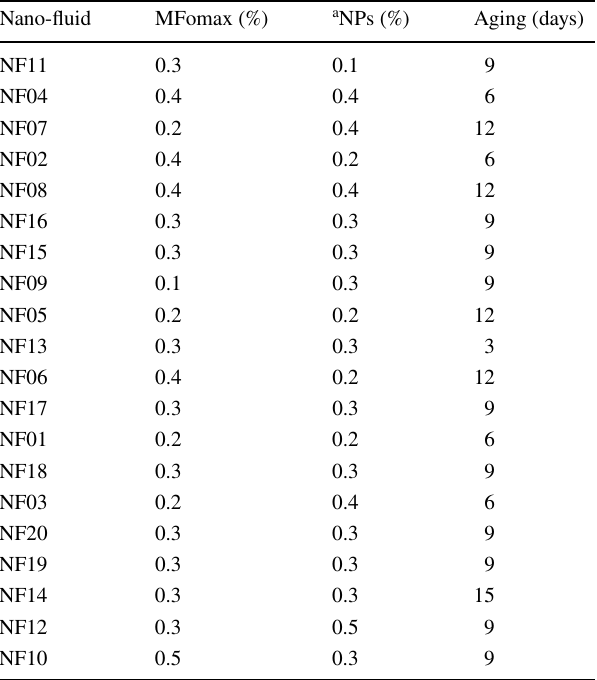
Table 2 Full matrix design of the NFs showing the concentrations of the NPs and MFomax used in each formulation and analyzed at dif- ferent aging times